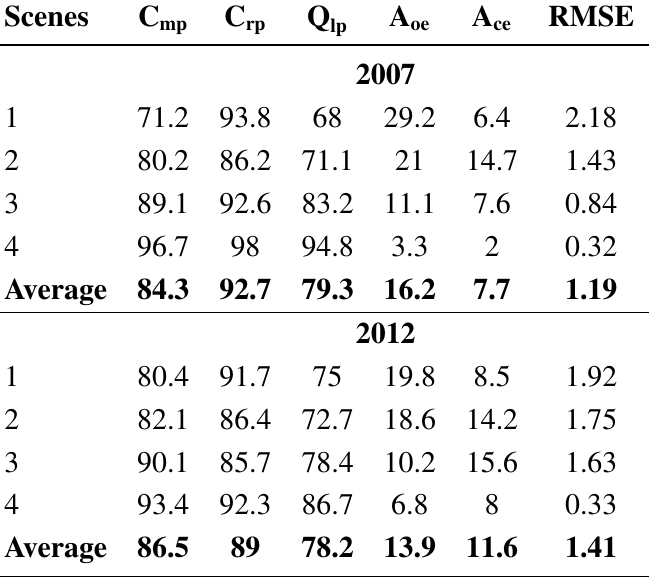
Table 4. Pixel-based building detection results. C Q = quality, A = area omission and A lp oe in